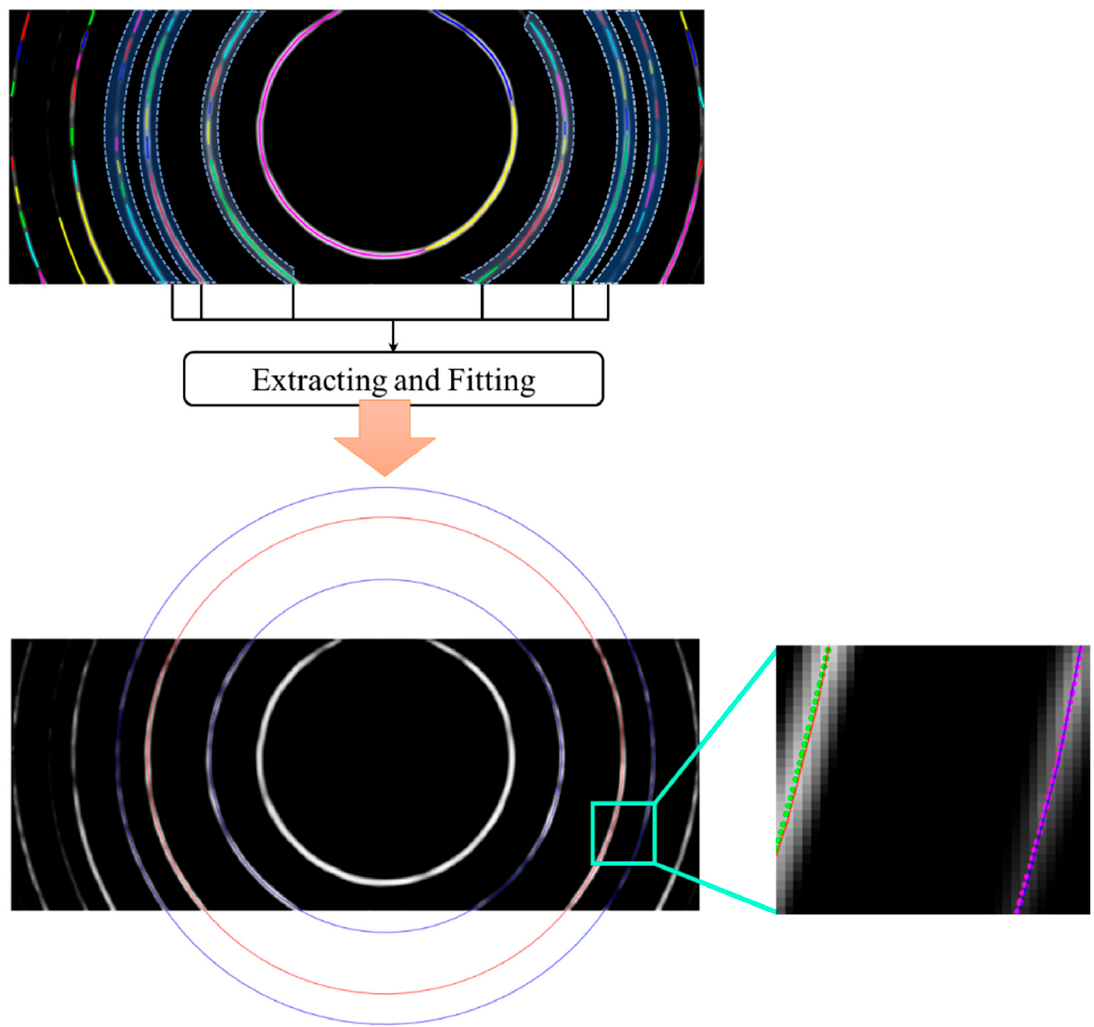
Figure 10. Spectrum processing of the experimental measurement.